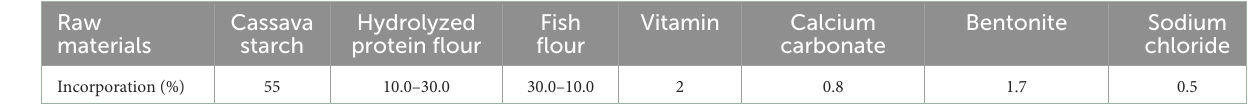
TABLE 2 Raw materials required for the preparation of the diet. Raw